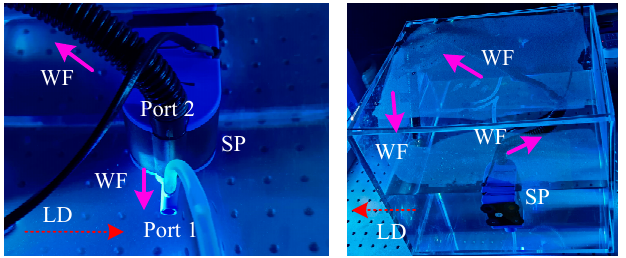
Figure 7. Relationship between the water flow (WF) and light direction (LD).